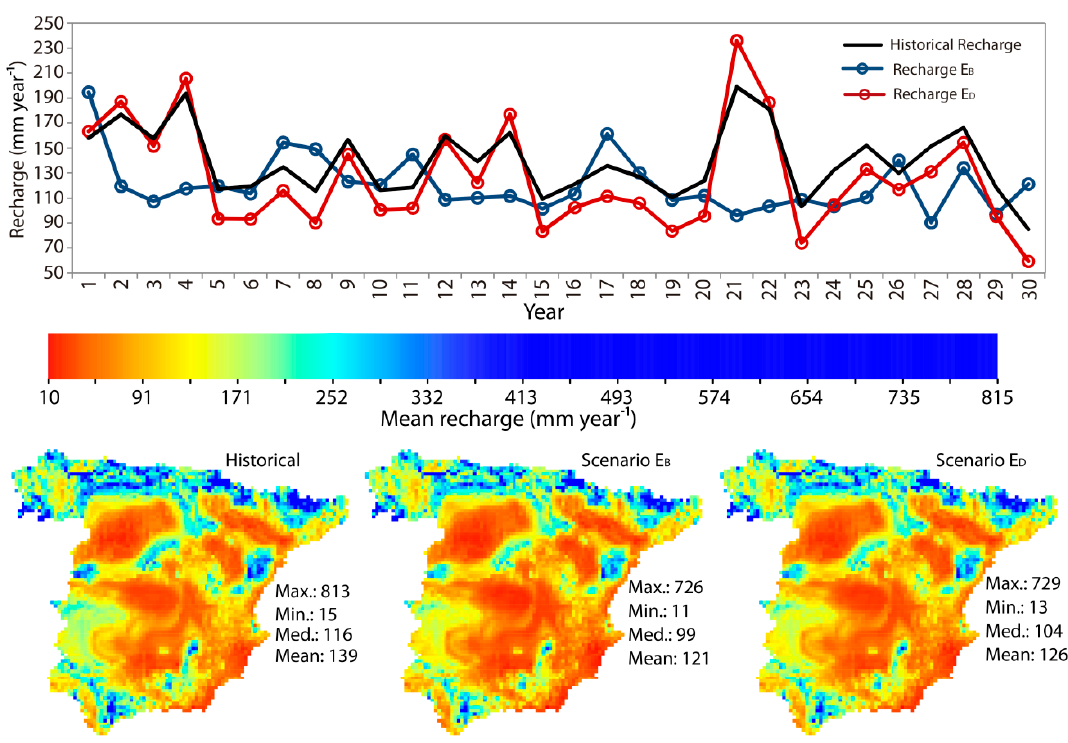
Figure 6. Historical (1976–2005) and future (2011–2045) potential R (mm year − 1 ) for the 2 defined equi-feasible ensemble scenarios. Modified from [29].